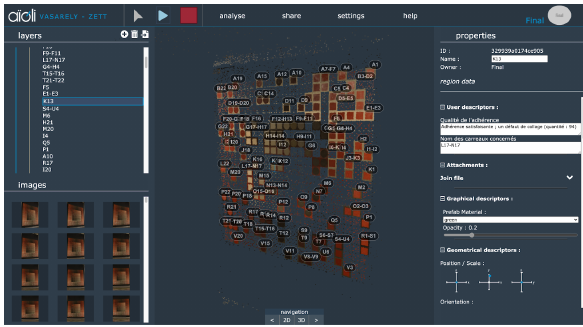
Figure 7 . Revealing detachments through 3D dense point- cloud annotations on « Zett